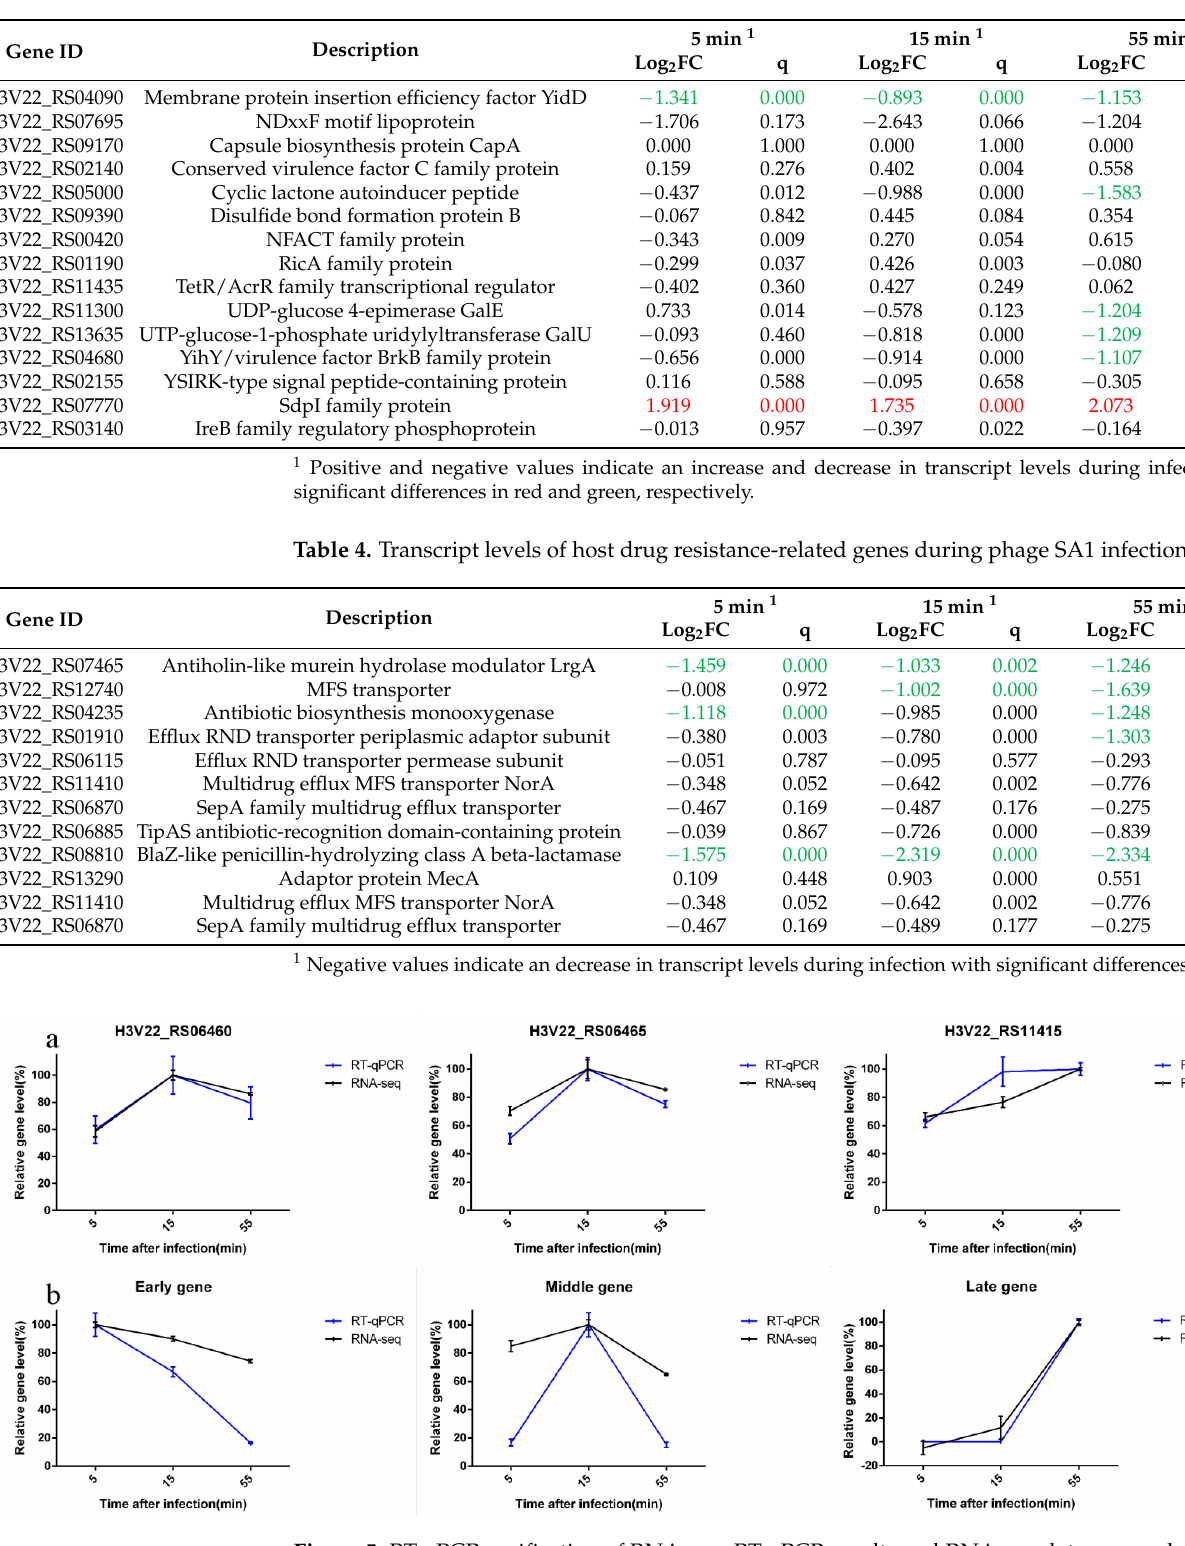
Figure 5. RT-qPCR verification of RNA-seq. RT-qPCR results and RNA-seq data were calculated by 2 − △ t and Log 10 (TPM) methods, respectively, and then normalized. ( a ) Verification using RT-qPCR for three TA system genes of S. lentus JTB1-3 upon infection. ( b ) Verification using RT-qPCR for three phage genes belonging to different stages upon infection. The data are expressed as means ± SD (n = 3). Graphs are plotted using GraphPad Prism 9.